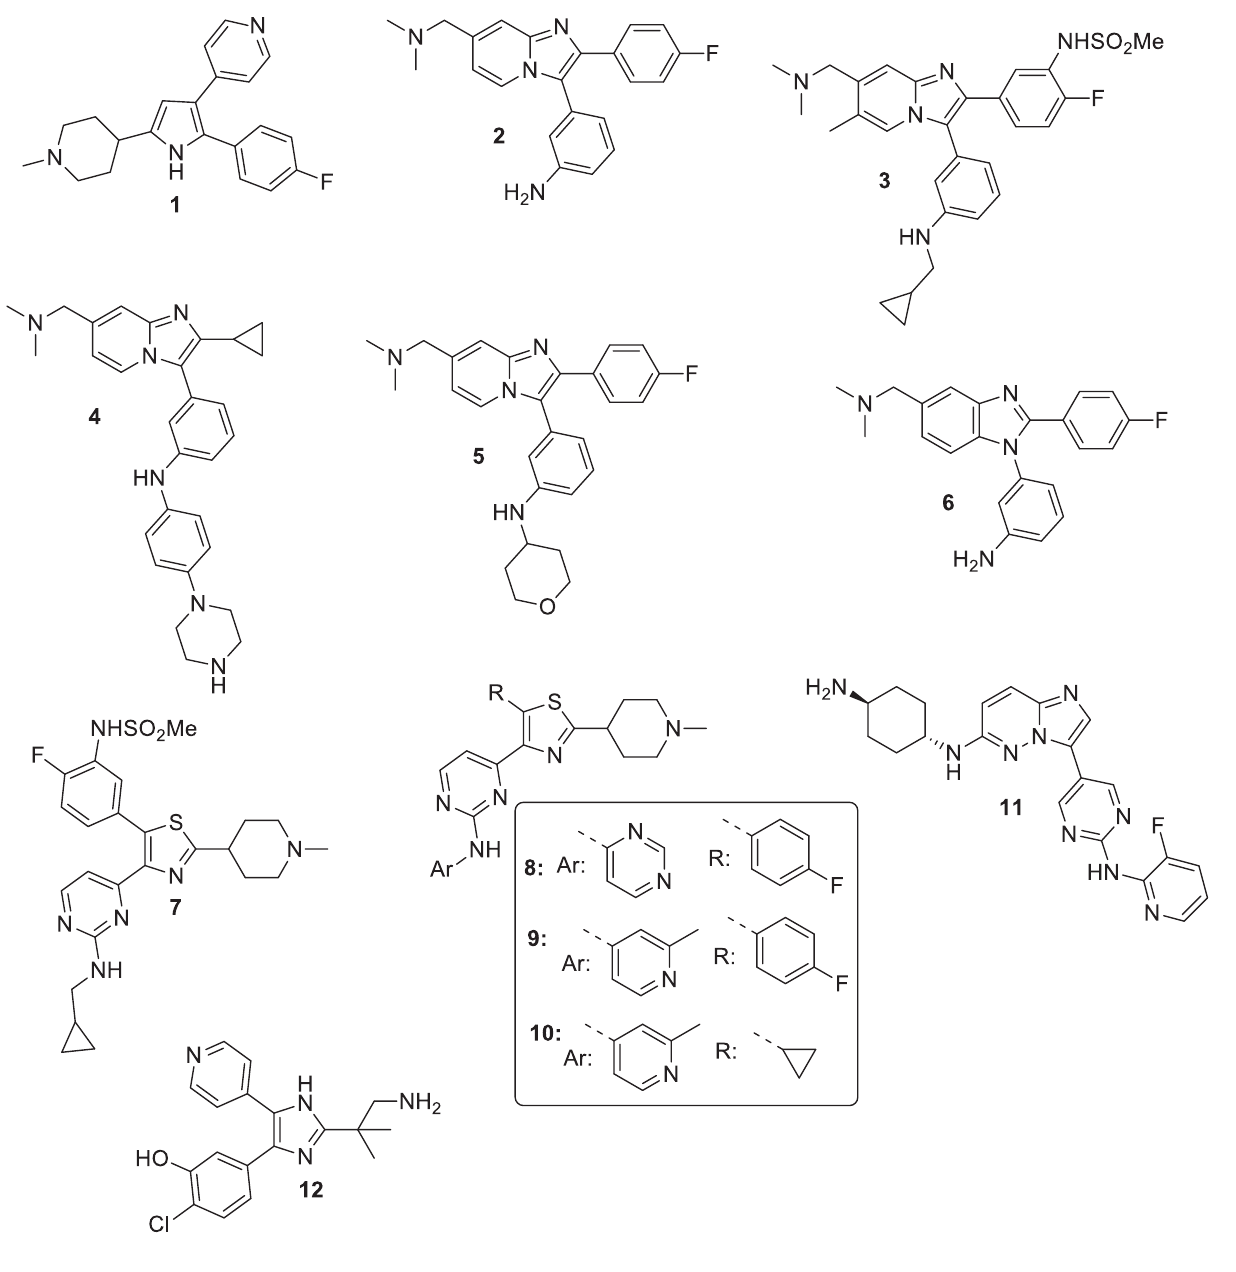
FIGURE 1 | Representative structures of PKG inhibitors mentioned in the